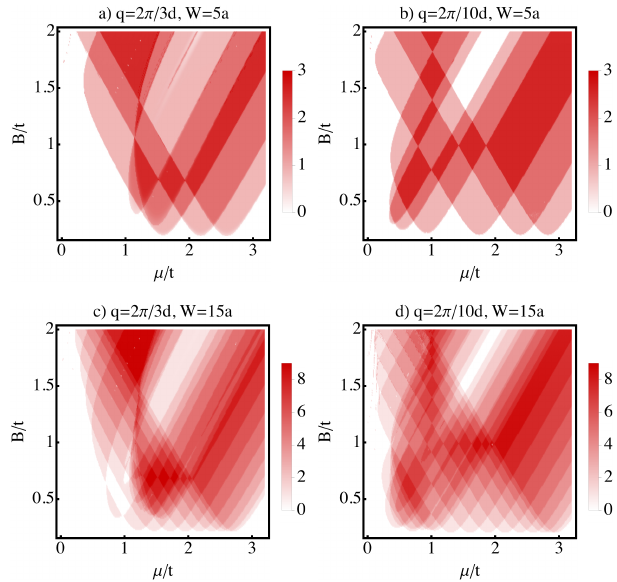
Figure 12: Z strips: Topological phase diagrams for strips with W = 5 a (upper row) and W = 15 a (lower row). We consider a wavevector of q = 2 π/ 3 d (left column, L = 86 a ), and q = 2 π/ 10 d (right column, b) L = 346 a and d) L = 173 a ). As before we take ∆ = 0.2 t .